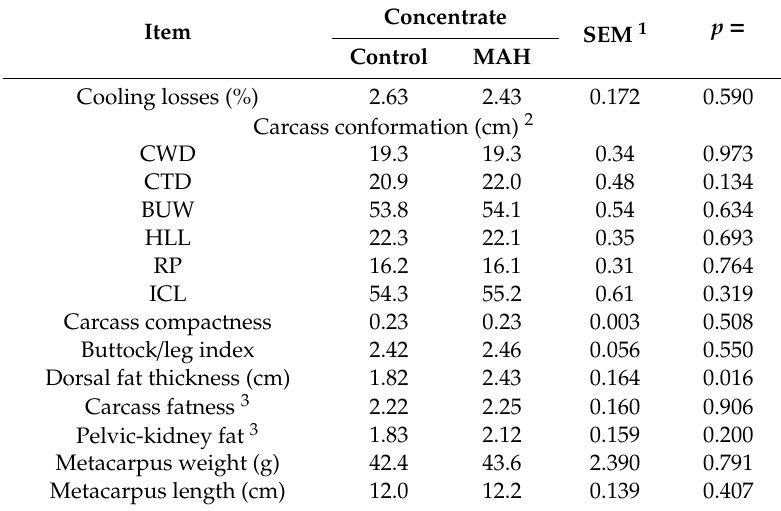
Table 1. Cooling losses, carcass conformation, and fatness measurements, and weight and length of the metacarpus of growing lambs fed barley straw and concentrate containing sunflower meal and seed either untreated (control) or treated with malic acid and heat (MAH).